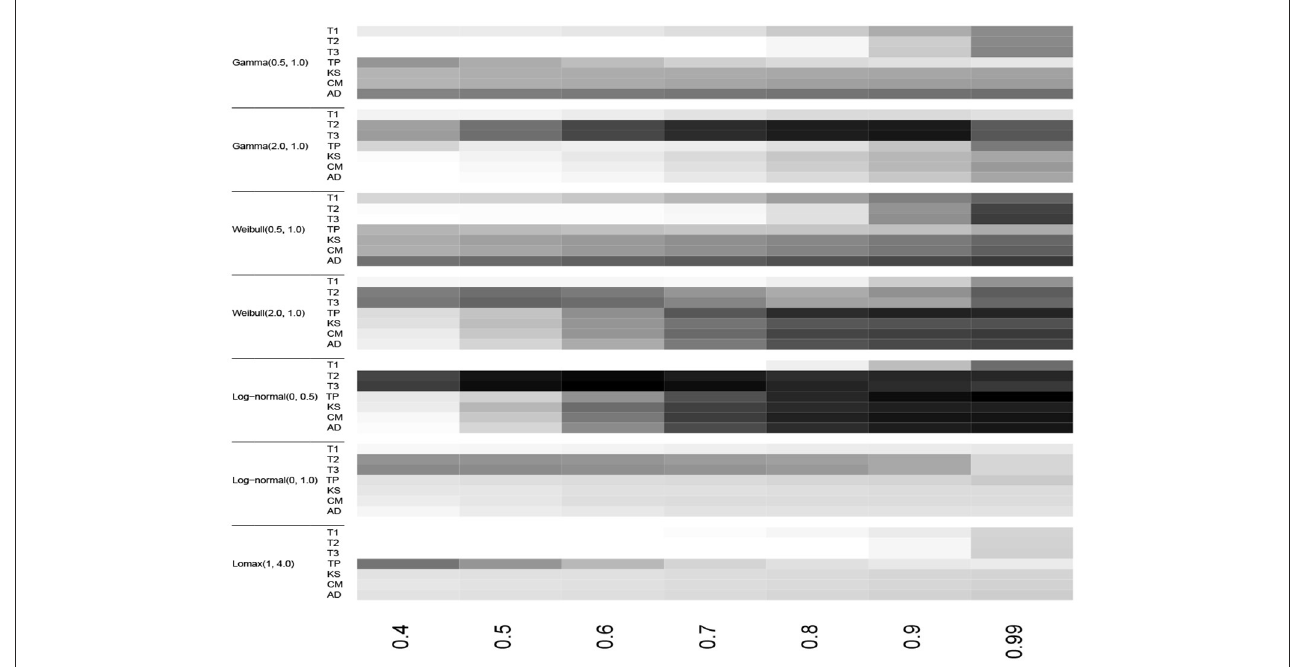
FIGURE4 Heatmap of the empirical powers listed in Table 3 for n